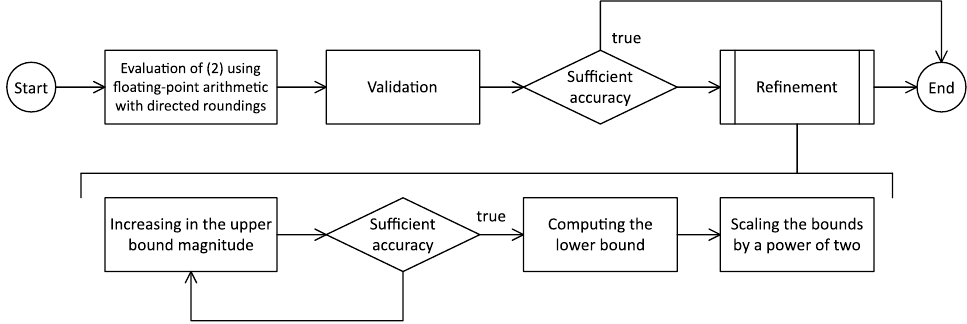
Figure 1. Accurate computation of the floating-point interval evaluation for an RNS representation using finite precision arithmetic. For a complete description and proof of the correctness of the algorithm, see